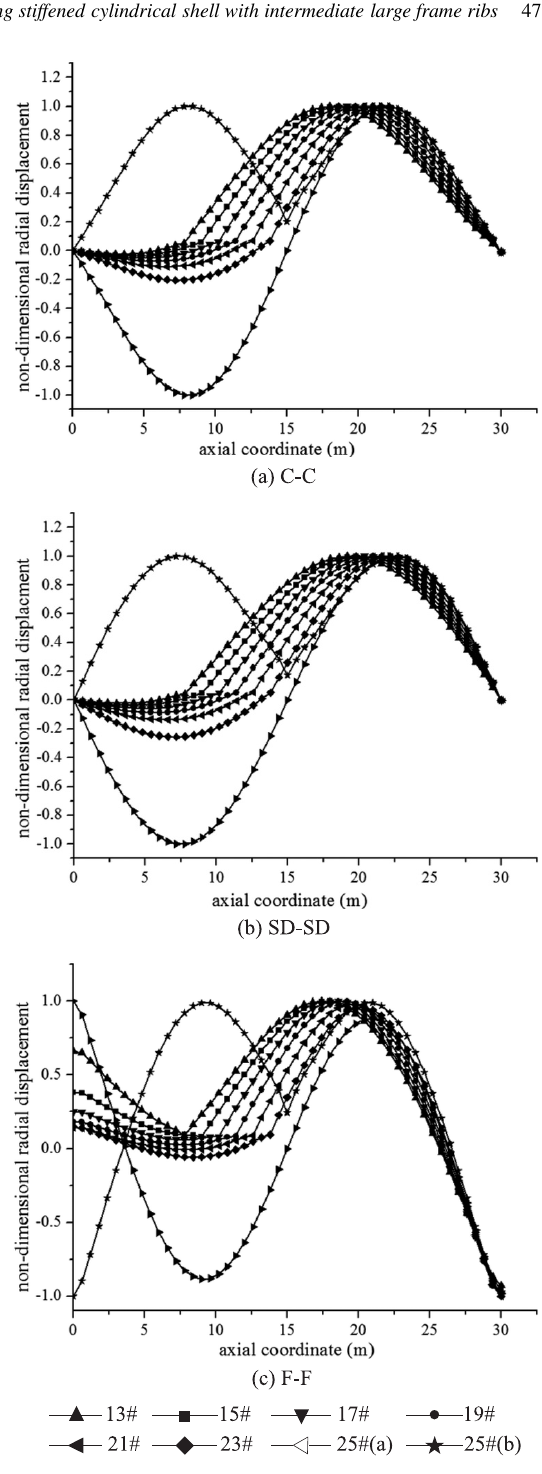
Fig. 14. Variation of vibration mode shapes with positions of the in- termediate frame